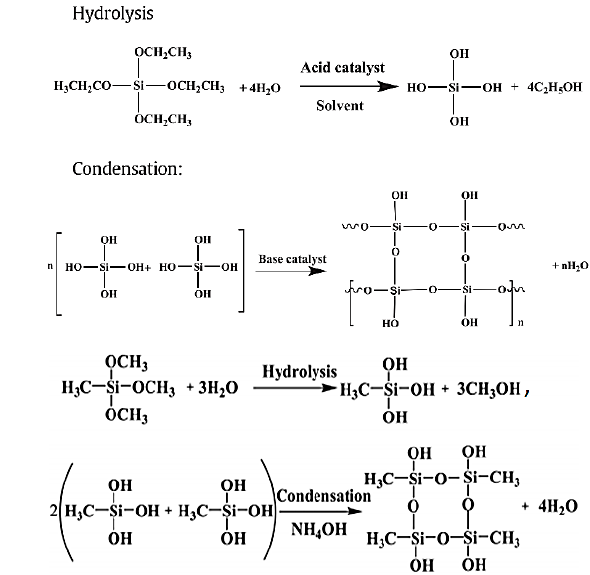
Scheme 1. The hydrolysis and condensation mechanism of TEOS ( a ) and MTMS ( b ) precursors in an aqueous